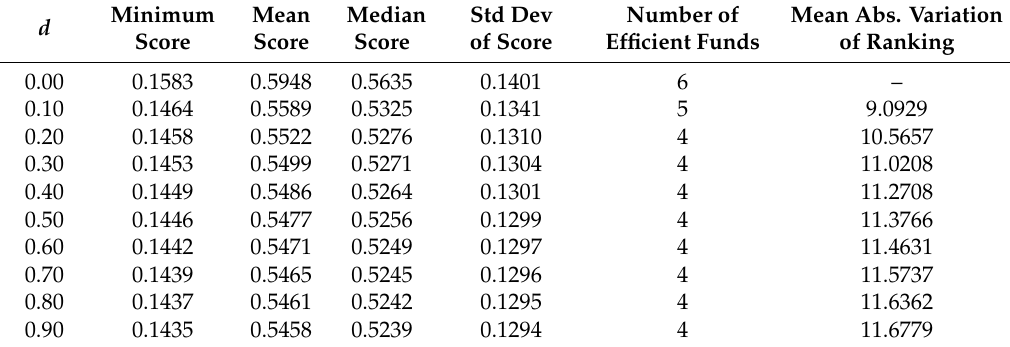
Table 12. Main results for AR restrictions in the case of symmetric bounds and T = 7. Summary statistics on the performance scores (minimum, mean and median values, standard deviation), number of efficient funds and mean absolute variation (divided by 2) of the ranking positions.